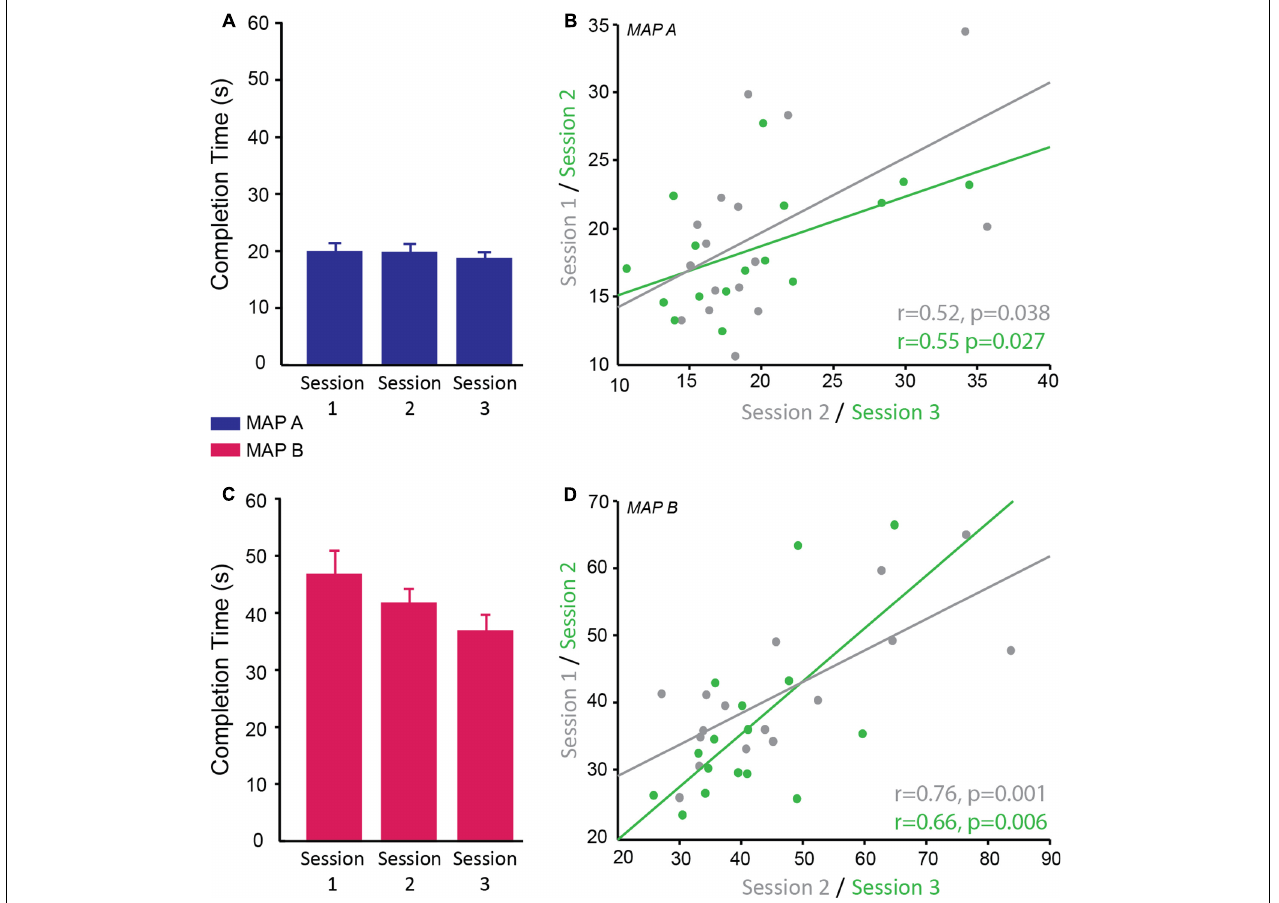
FIGURE 5 | Reliability of completion time on the trail making test. (A,C) Completion time (s) of trail map A ( A ; blue) and map B ( C ; pink) across sessions. There was no significant interaction between map and session therefore it cannot be concluded that map A showed different reliability across sessions compared to map B; however, qualitatively the data suggests map B may be more susceptible to practice effects than map A. (B,D) Significant positive correlation of completion time on trail map A (B) and trail map B (D) between sessions 1 and 2 (gray) and sessions 2 and 3